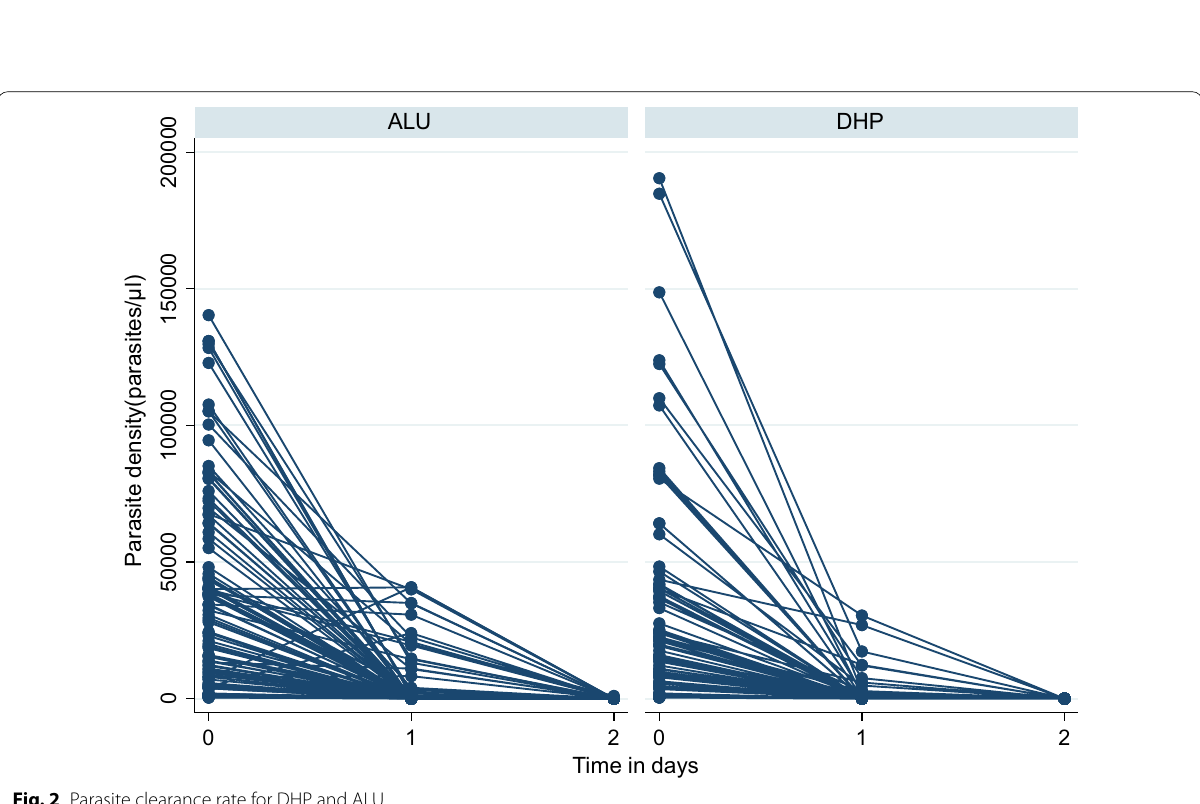
Fig. 2 Parasite clearance rate for DHP and